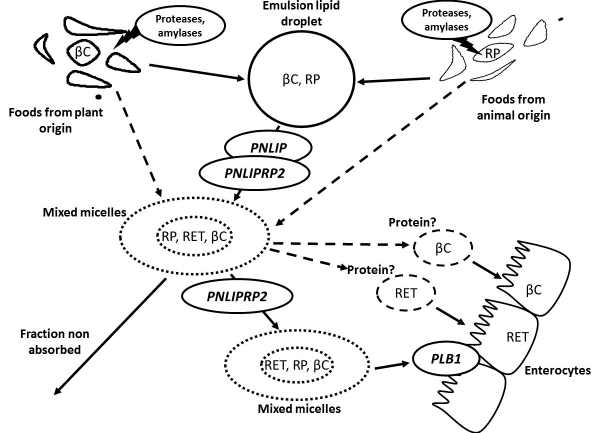
Figure 1. Proteins involved, or hypothesized to be involved, in vitamin A (VA) metabolism within the lumen of the upper gastrointestinal tract. β C: β -carotene and all other provitamin A carotenoids; PLB1: phospholipase B; PNLIP: pancreatic lipase; PNLIPRP2: pancreatic lipase-related protein 2; RET: retinol; RP: retinyl palmitate and all other retinyl esters. Proteins followed by a question mark have been hypothesized to be involved because RET and β C are not soluble in water, and thus,